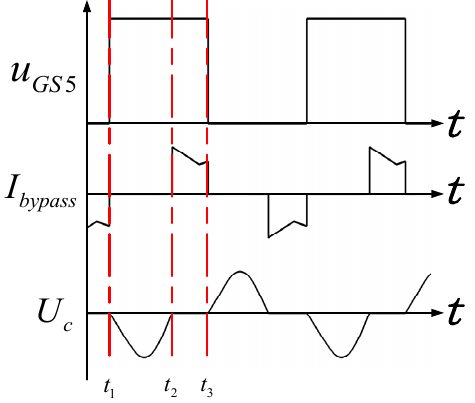
Figure 9. Soft switching diagram of the LLSC converter’s additional MOSFETs.